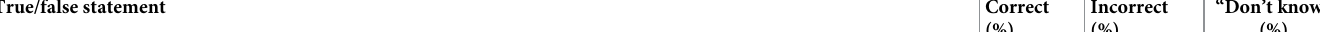
Table 5. Client’s knowledge of HC-HIV counseling messages: True/false percent distribution of knowledge about hormonal contraceptive methods and associated risk of HIV acquisition among women ages 17–49, N = 471, Tanzania 2018. True/false statement